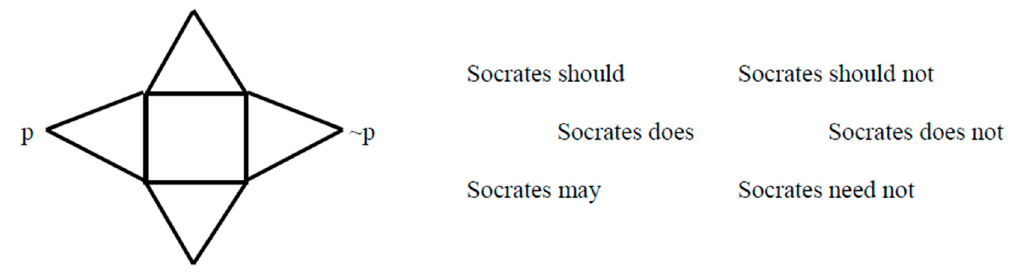
Figure 7. The octagon of good behavior.